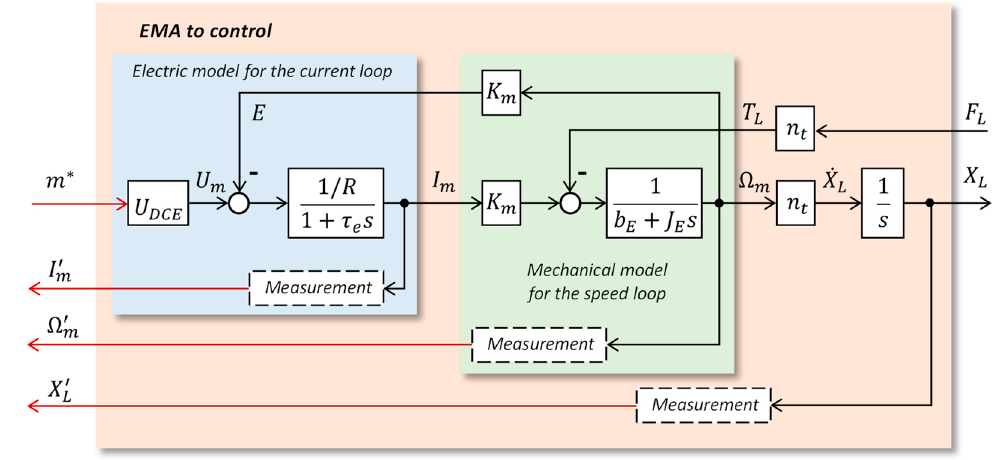
Figure 2. Block-diagram representation of the equivalent linear control model of the EMA to control (see Appendices A and B for details).